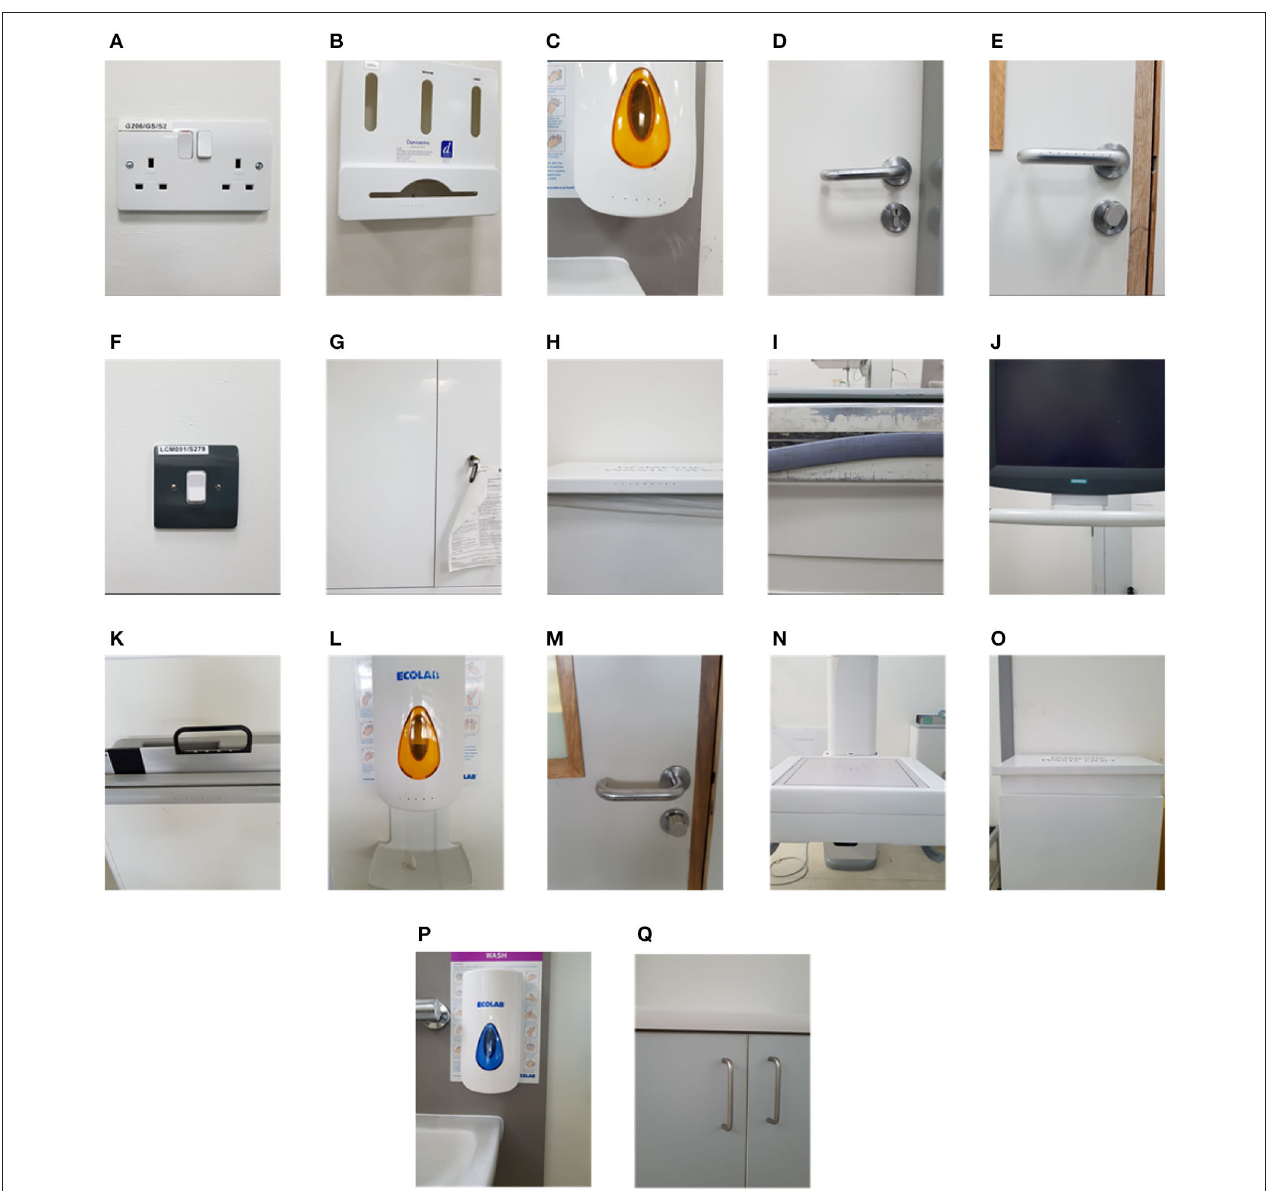
FIGURE 3 | Commonly touched surfaces chosen for swab testing in hospital 1: (A–J) CT scan room; (K–Q) interventional suite.